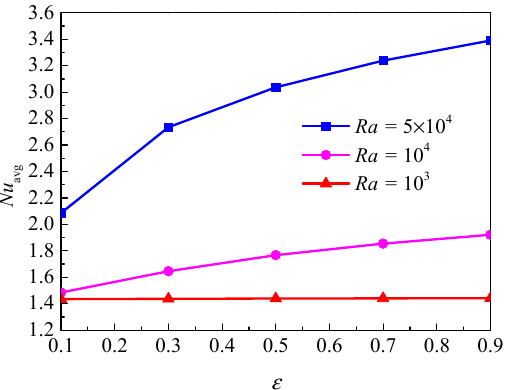
Figure 15. Average Nusselt number ( Nu avg ) of the inner wall for different porosity ( ε ) and Rayleigh numbers ( Ra ) at Da = 10 − 2 , ϕ = 0.05, d sp = 50 nm, and RR = 2.